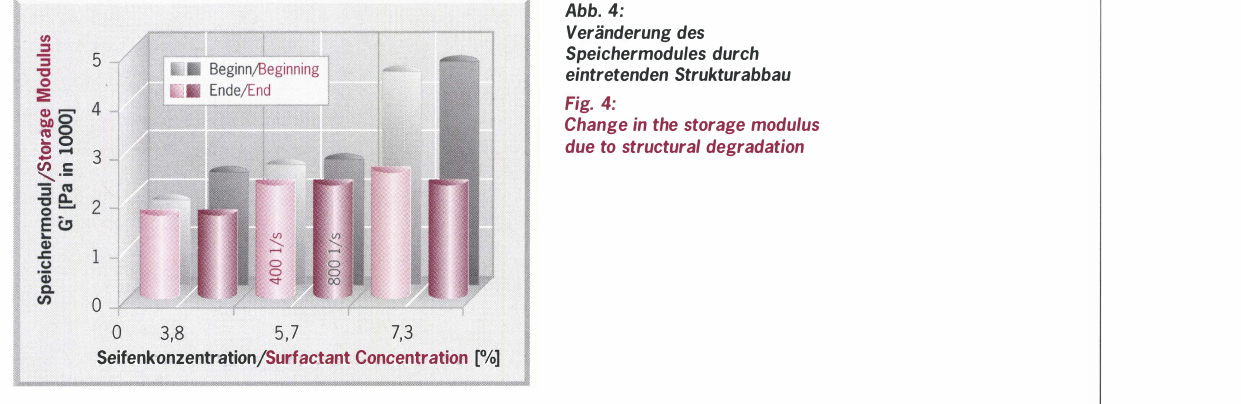
Vv and VR are wear and friction volume. The speed Of Ch an ge Of e*Rrheo iS described With e ,1 (J/m3 S). Small values of e ,1 can be interpreted as the capacity of the lubricating grease to absorb lots of energy.